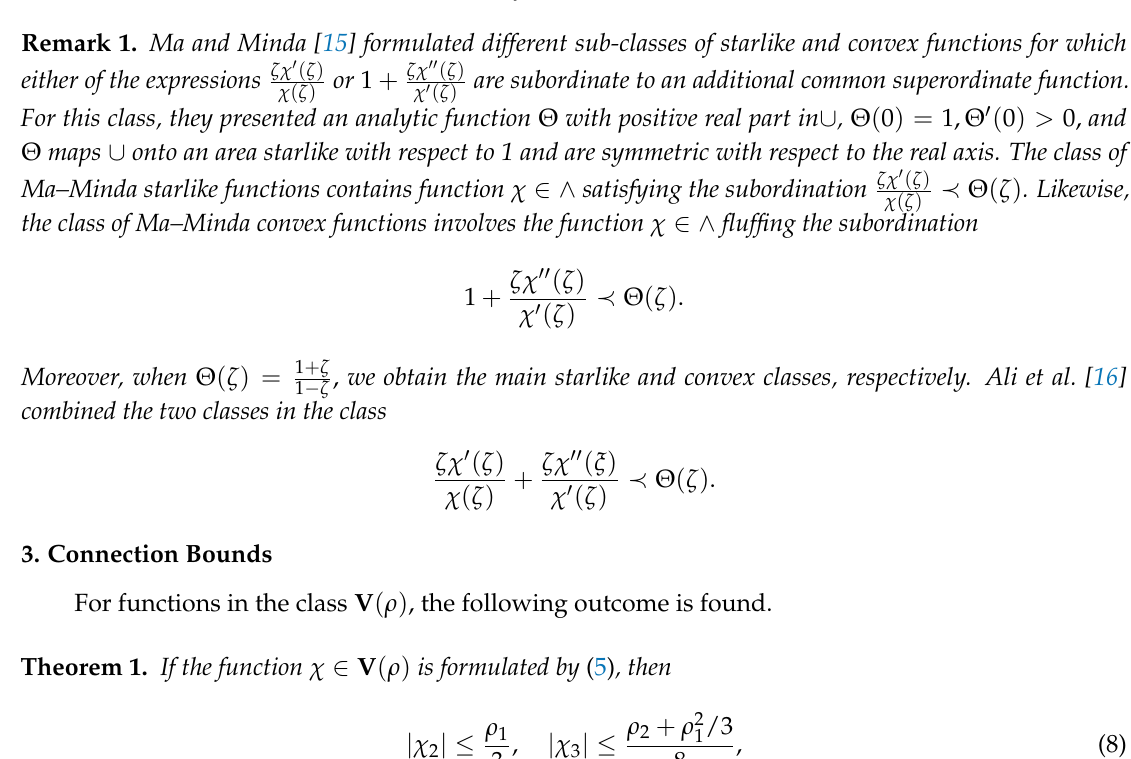
(cid:16) (cid:17) ζ and sin 1 − ζ